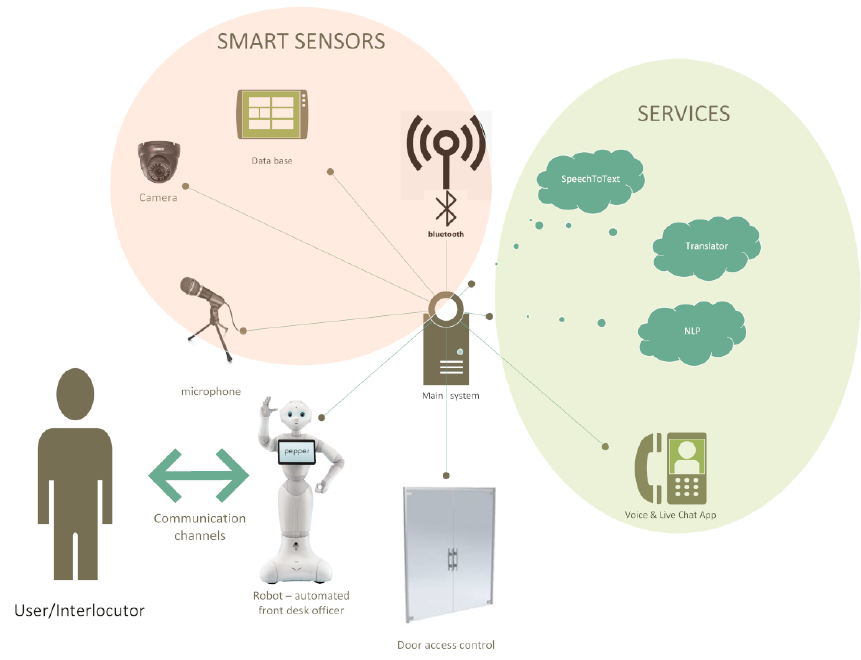
Figure 1. Simplified overview diagram of the proposed system’s